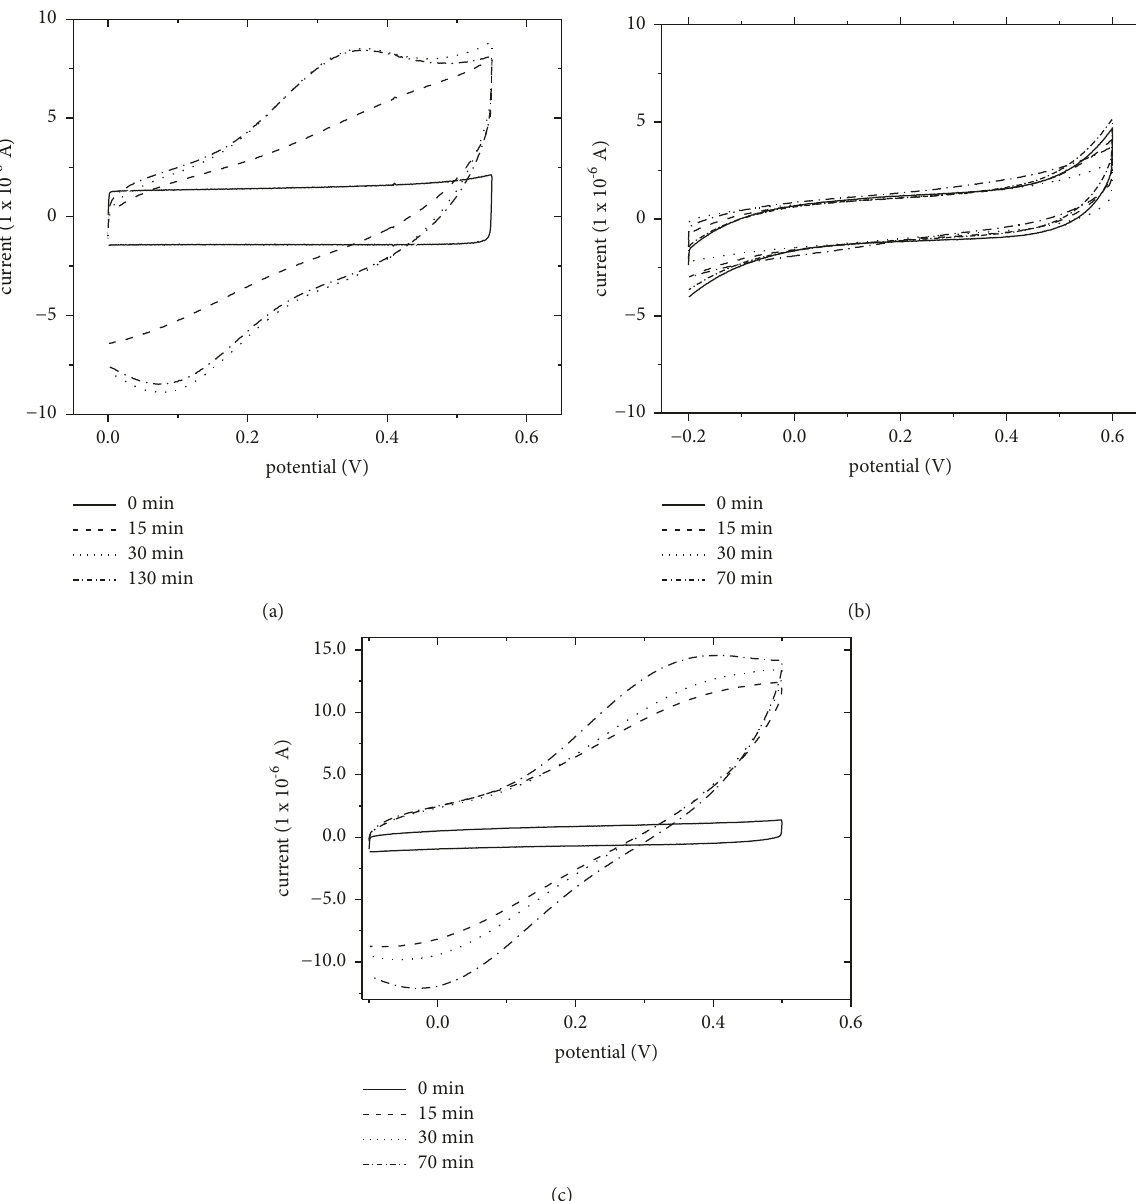
Figure 4: Cyclic voltammetry measurements on PMPMS layers crosslinked for 17 hours with 1 mM (a) BMH and (b) BMDPM in DMF. The cured layers were immersed in 80 ∘ C deionized water for the indicated time, after which they were immersed in K 3 Fe(CN) 6 solution for the CV measurements. PMPMS deposition: 10 mM PMPMS in DMF, 2 h. Data for an uncrosslinked PMPMS layer are shown in